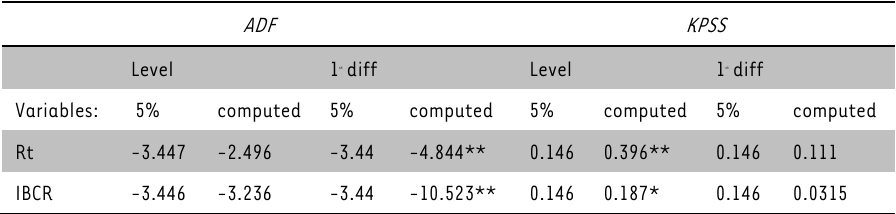
TABLE 2: Unit Root and Stationarity Tests Results ADF KPSS Level 1 st diff Level 1 st